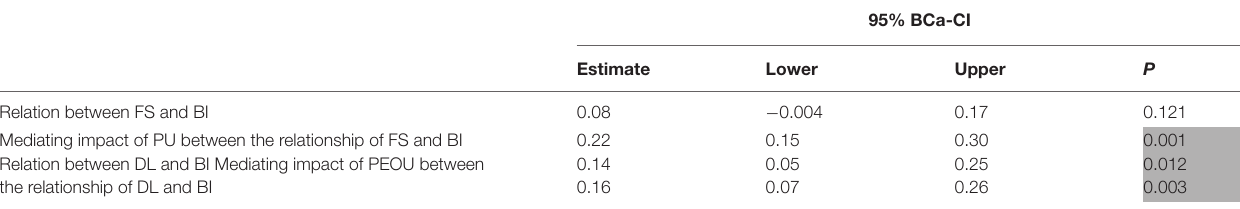
TABLE 5 | The mediating roles of perceived usefulness and perceived ease of